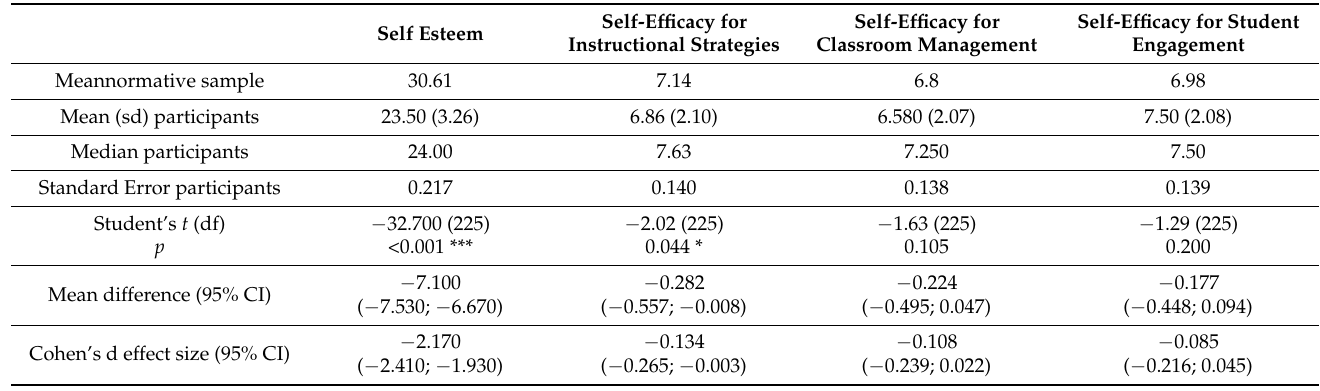
Table 2. Comparison between mean scores of participants and normative samples.